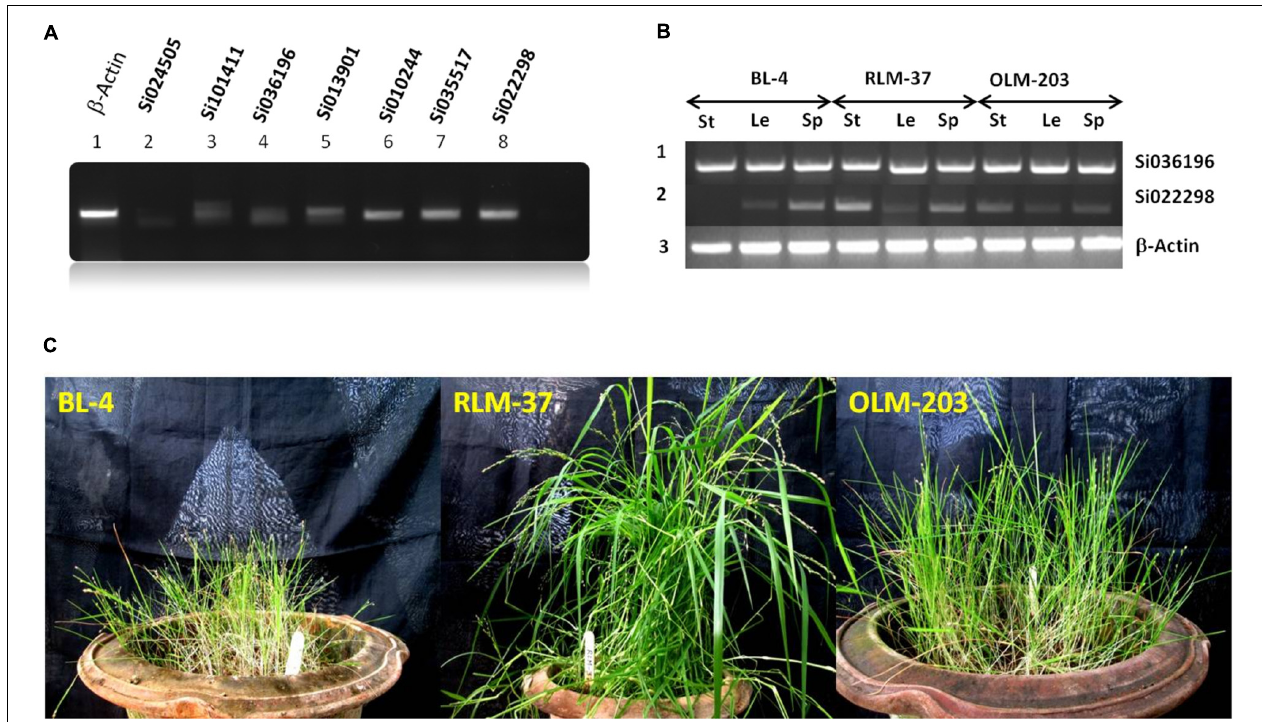
FIGURE 6 | (A) RT-PCR expression analysis of seven ZIP genes from S. italica in shoot tissues. (B) Differential expression analysis of ZIP family gene in little millet. Le, leaf; St, stem and Sp, spica. (C) Standing crop view of little millet